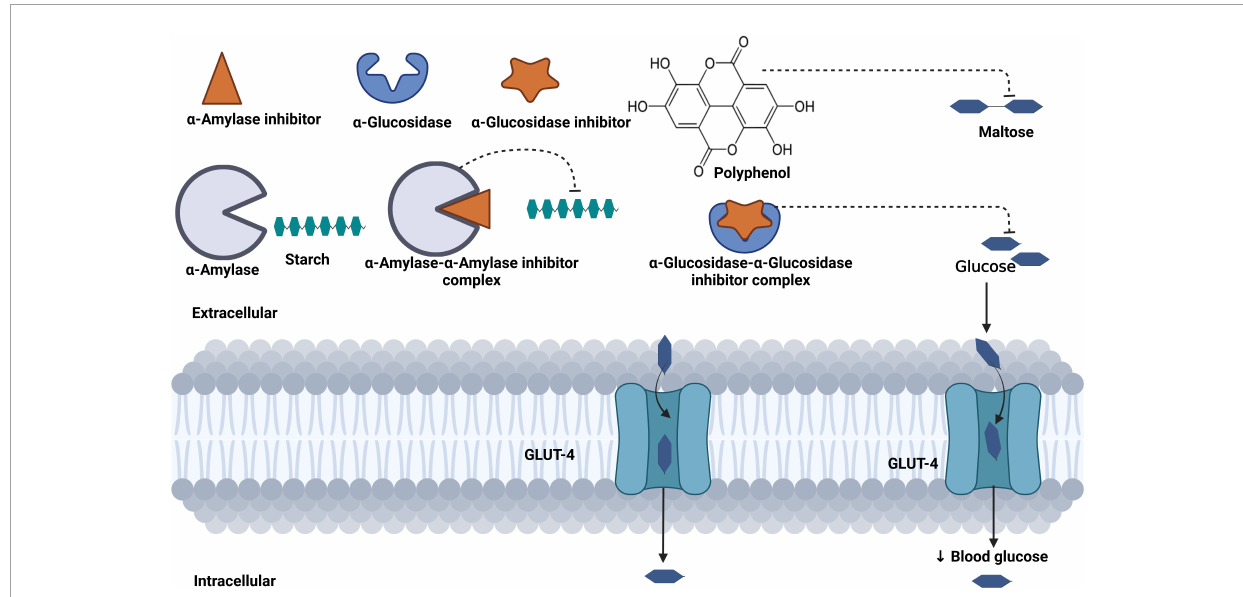
FIGURE4 Mechanism of blood glucose regulation mediated by phenol content in Corchorus olitorius . Polyphenols inhibit starch-digesting enzymes ( α -amylase, β -glucosidase), reduce the breakdown of starch into maltose, and further reduce the transportation of glucose in the bloodstream.